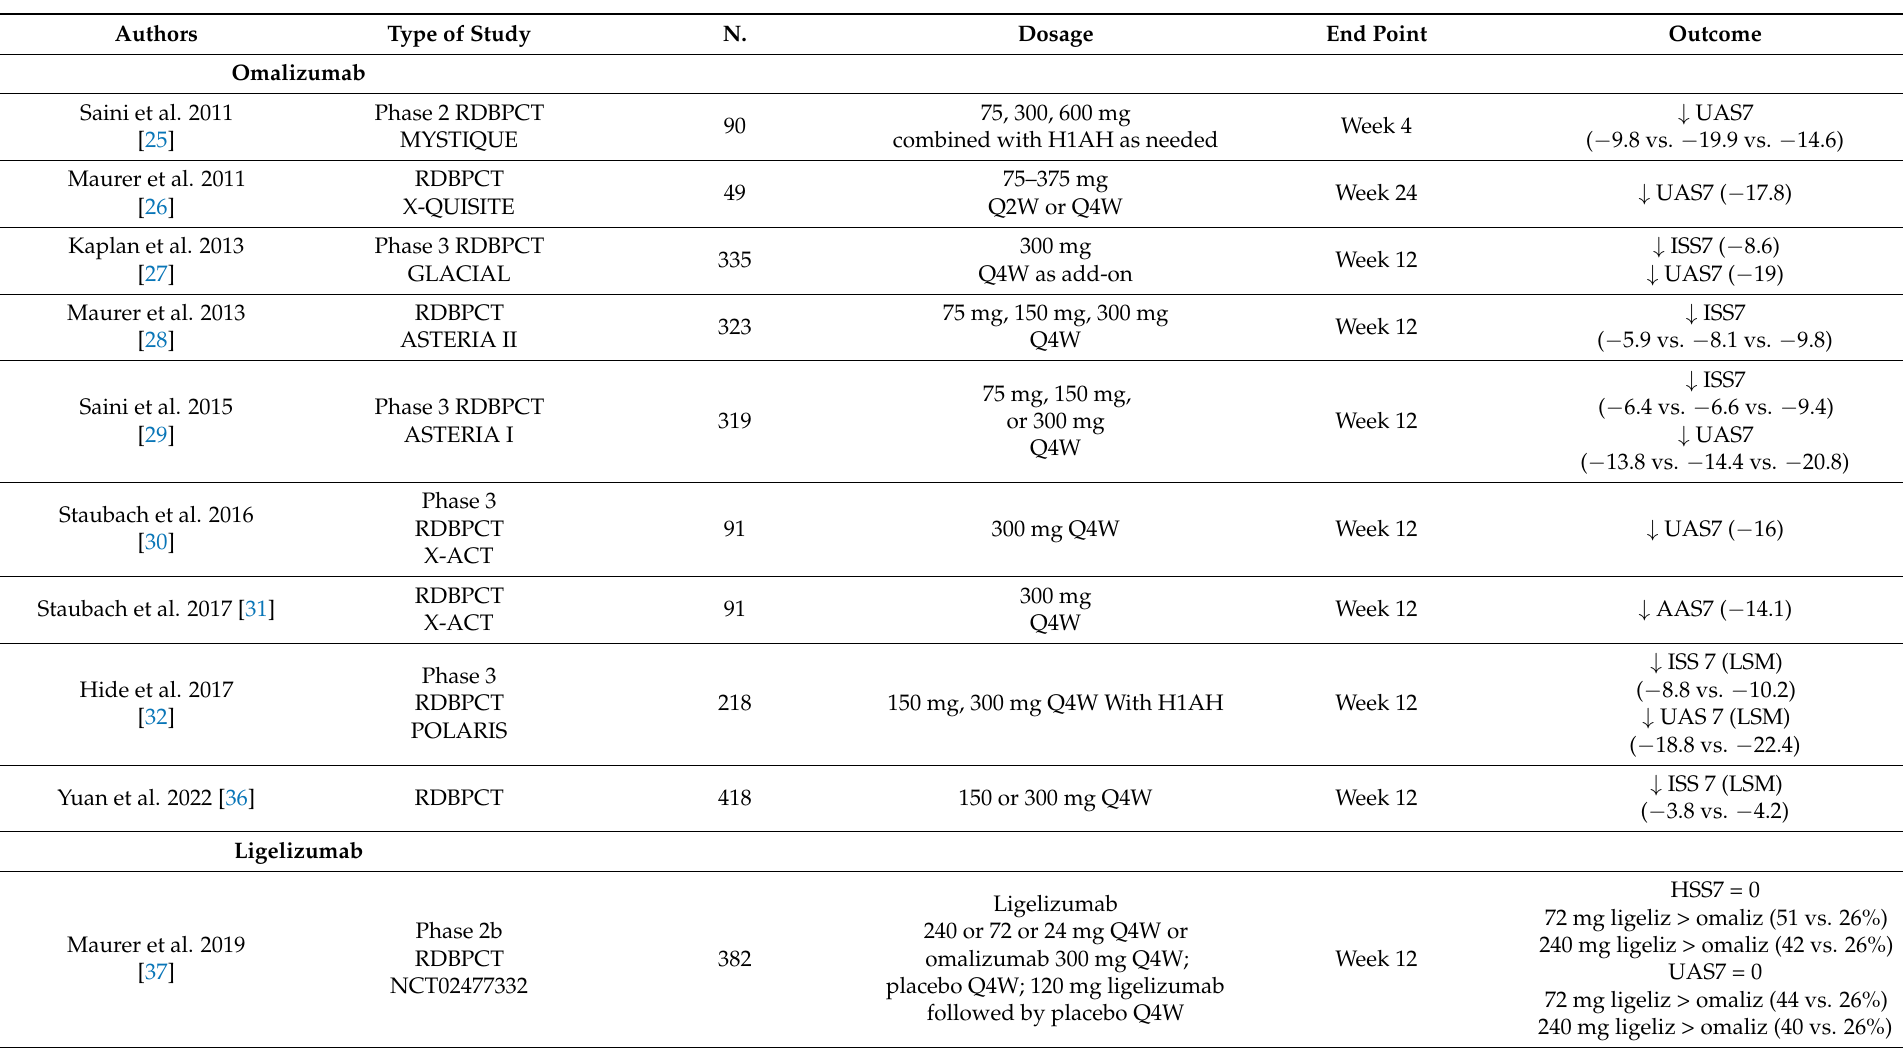
Table 3. List of the studies on biologics in CSU reporting disease severity score as an